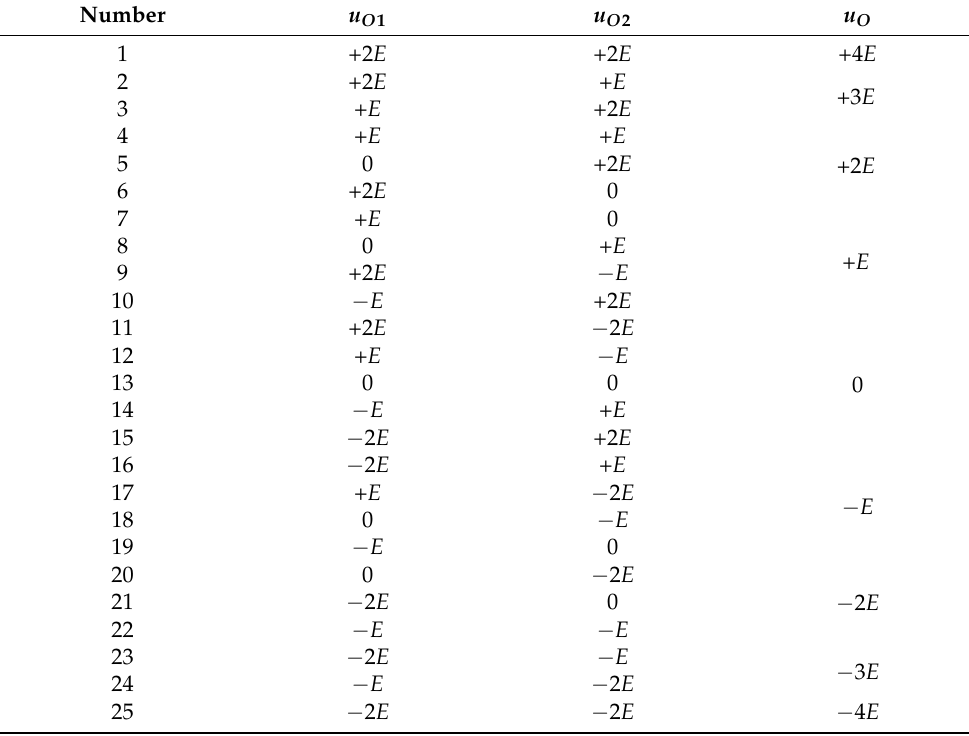
Table 1. Working status of the cascaded inverter.